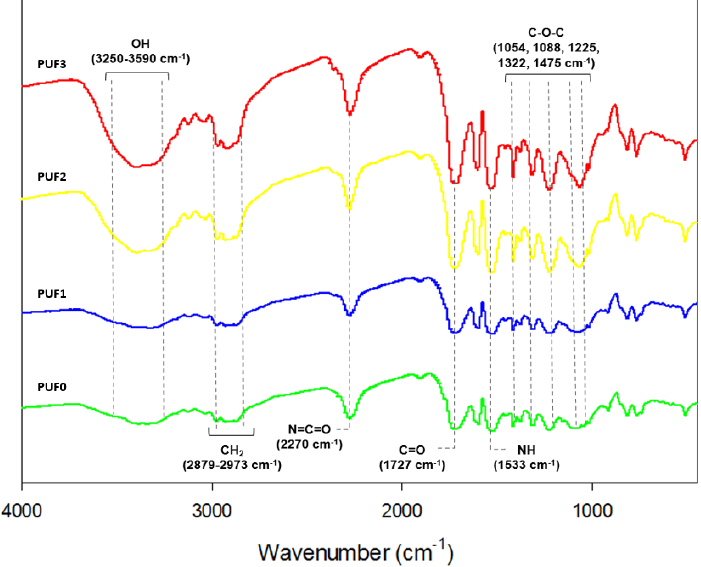
Figure 7. FT-IR spectra of neat polyurethane foam and biopolyurethane foams.